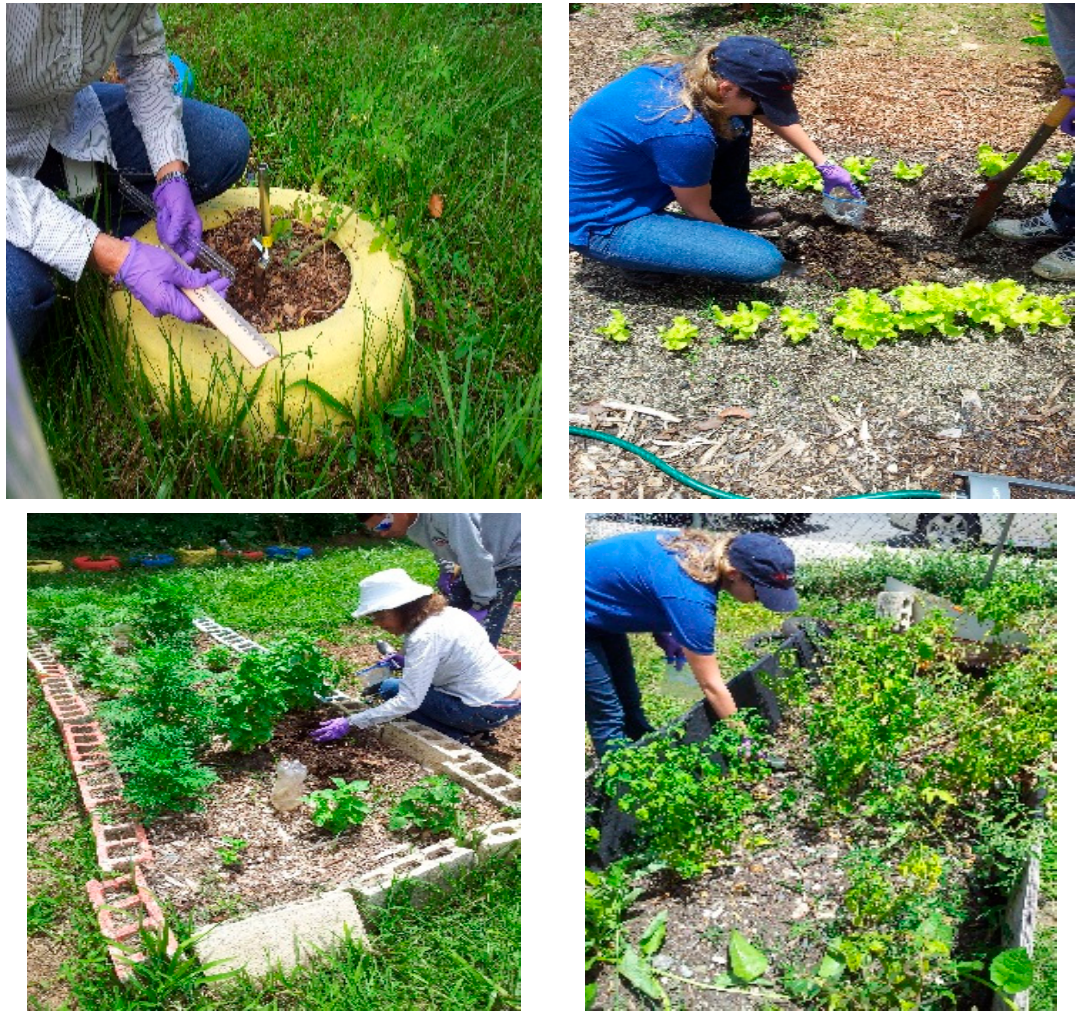
Figure 2. Examples of raised beds from the urban community gardens evaluated in this study.